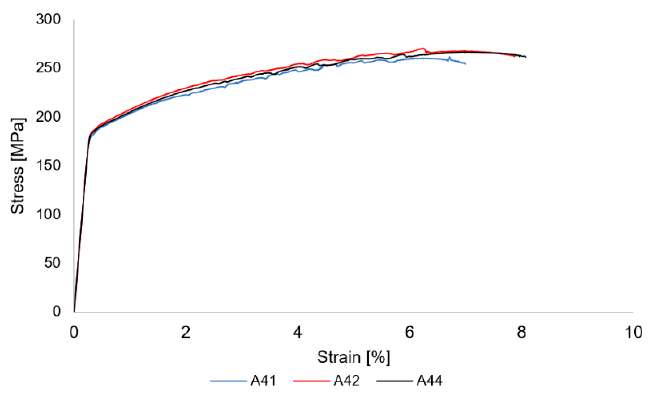
Figure 6. Tensile curves for joints obtained with the tool rotation speed of 400 rpm.